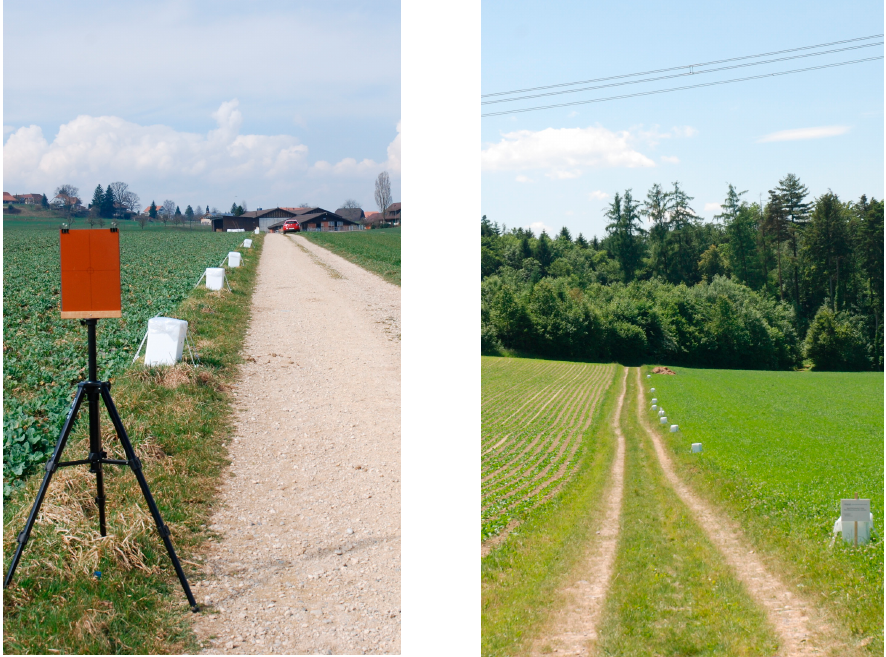
Figure 8. Measurement setup with the (white) measurement boxes in Iffwil ( left ) and Wiler ( right ). Only the right image shows the entire length of the measurement path with all nine boxes. Also shown in the left picture is the target table that was used with the laser distance meter to position the boxes and to measure the height to the conductors. and to measure the height to the